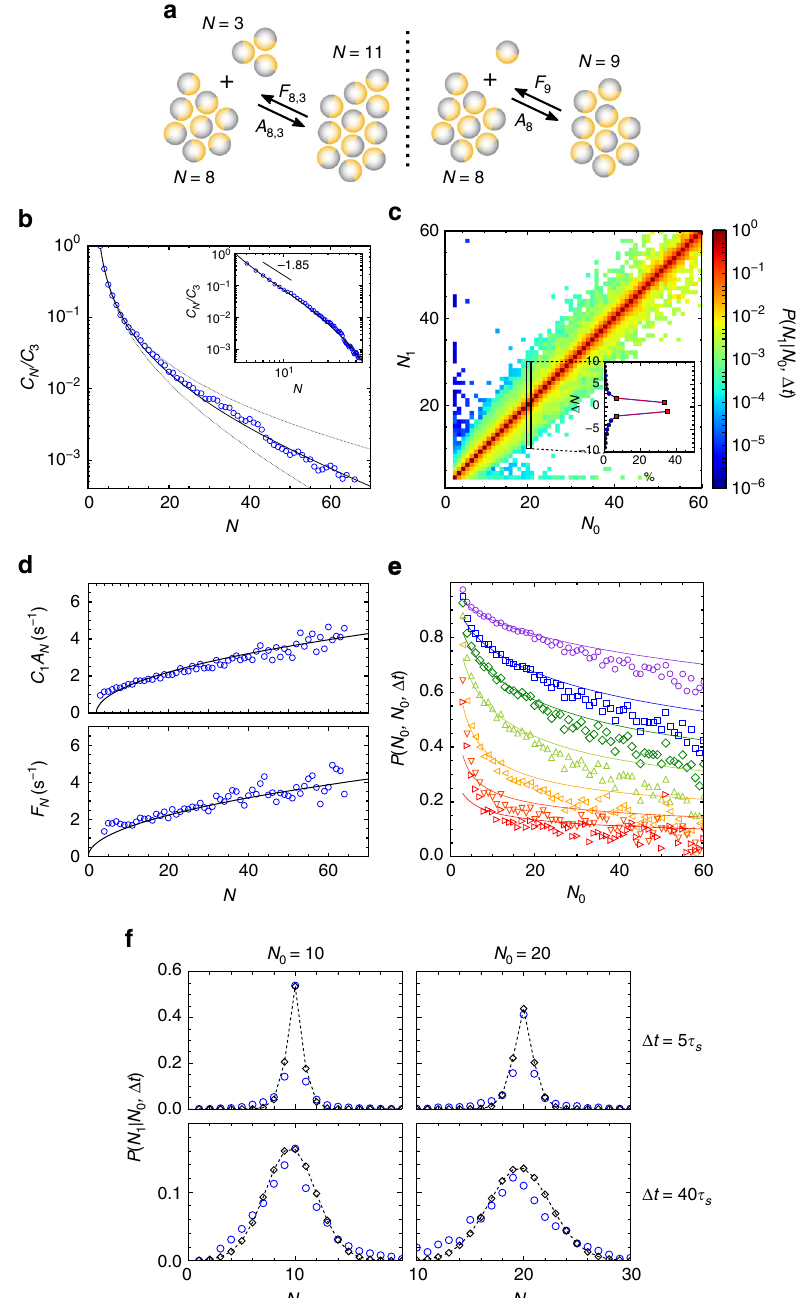
Fig. 2 Aggregation – fragmentation process in active clusters. a Sketch of the events considered without and with the monomer approximation (left and right respectively). b – f Experimental data for activity v 0 = 8.6 μ m s − 1 and area fraction Φ = 9%. b Cluster size distribution in semilog scale evidencing the exponential decay at large size. Symbols: experimental data and solid line: theoretical fi t (see main text). The dashed lines show the effect of the 2% relative uncertainty on κ , obtained upon assuming a 10% relative uncertainty on all data points for CSD and rates. Inset: same data in loglog scale to emphasize the power law regime at small size. c Transition matrix showing the probability P N 1 j N 0 ; Δ t ð Þ for a cluster of size N 0 to have a size N 1 after a time lag Δ t = τ s = 0.05 s. d Aggregation and fragmentation rates for monomeric events. Symbols: experimental data and solid line: theoretical fi t (see main text). e Probability P N 0 j N 0 ; Δ t ð Þ that a cluster of size N 0 has the same size after a time Δ t = 1, 2, 3, 5, 10, 20 and 40 τ s , from top to bottom. f Transition probability j N ; Δ t ð Þ for N = 10 and 20, Δ t = 5 τ = 0.25 s and 40 τ = 2 s. Blue circle: experimental data and black losange: prediction of Eq. P N 1 0 0 s s